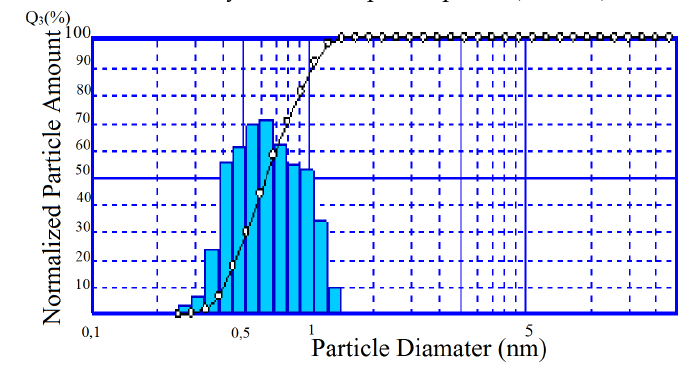
Figure 9. Particle size distribution in TSK. Table 4. TSK surface and technical